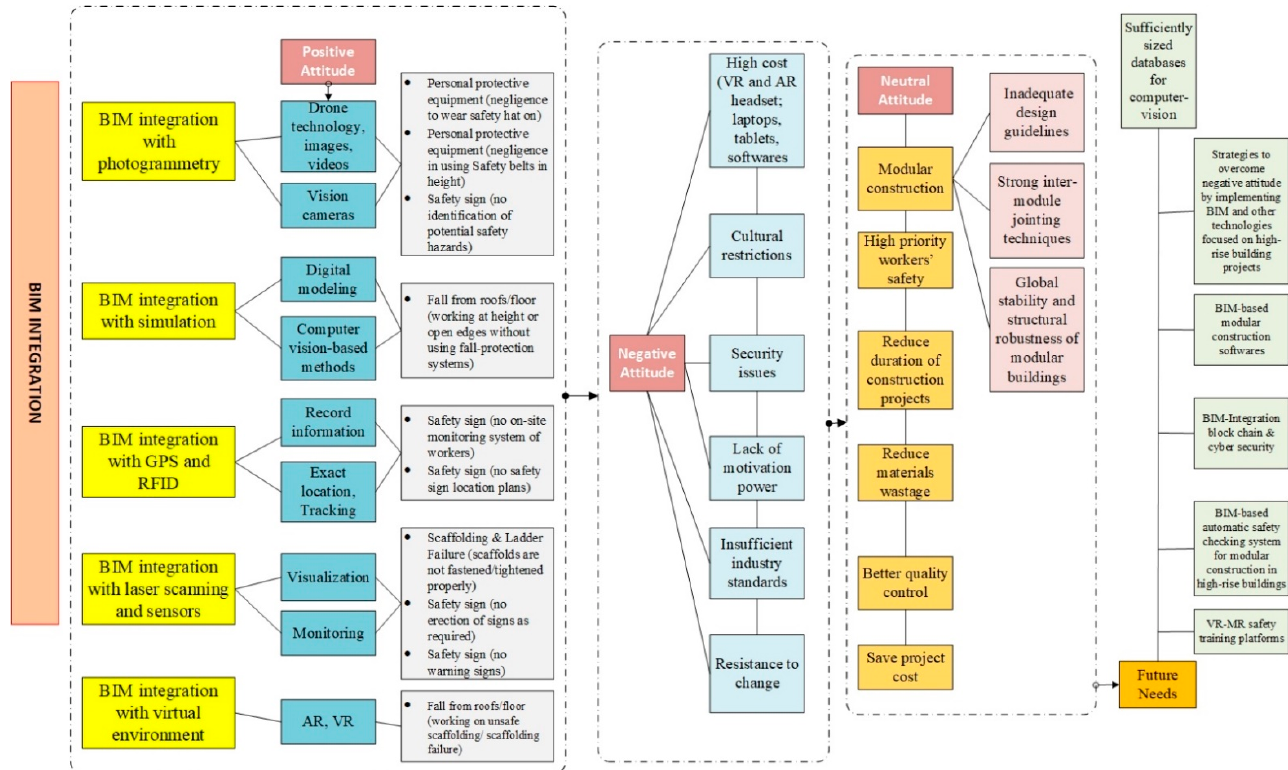
Figure 3. A research framework for the integrated BIM and emerging digital technologies in mitigating construction accidents in high-rise